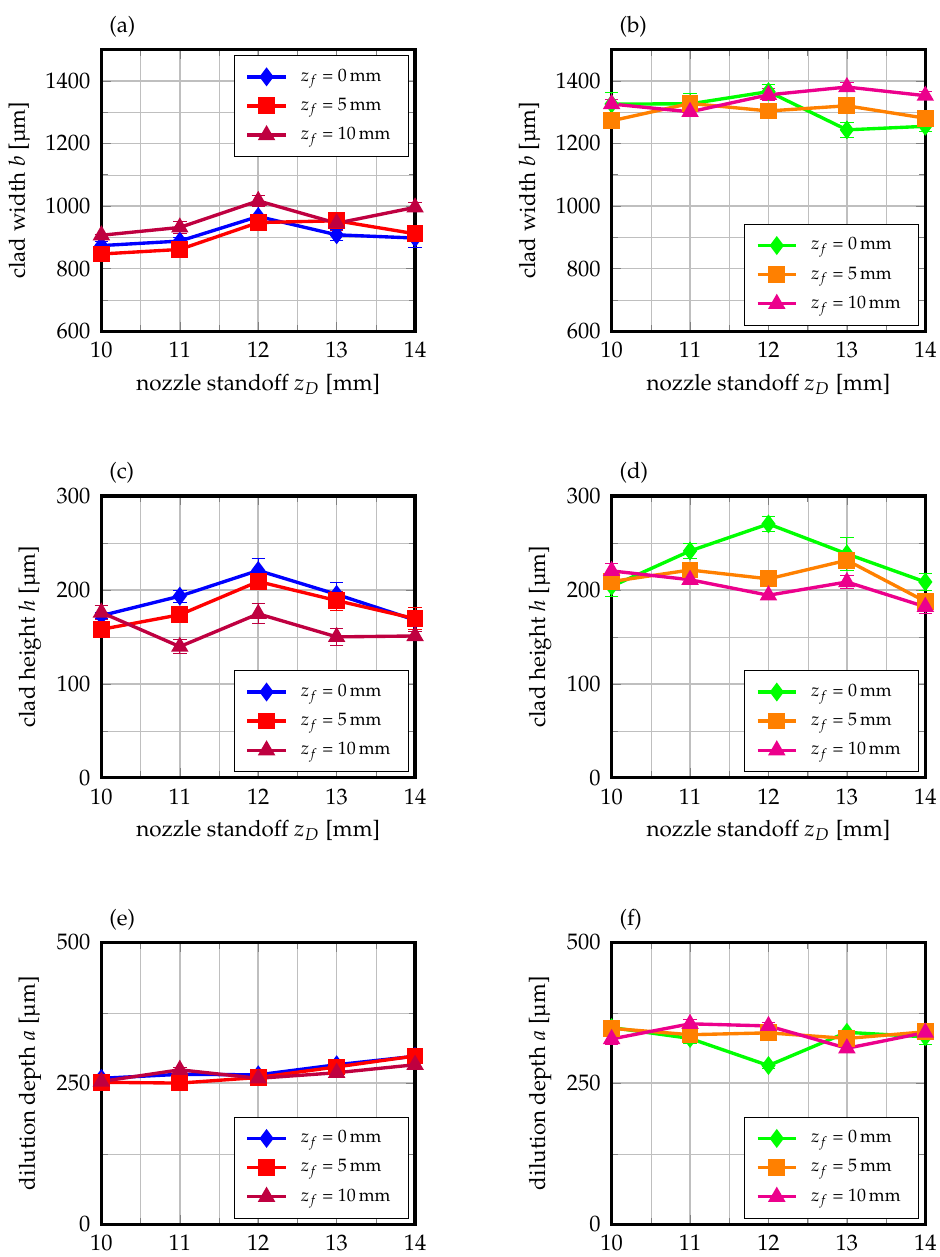
Figure 8. Evolution of target values’ clad width b , clad height h , and dilution depth a for varying nozzle standoff distances z D and focal offsets of the laser beam z f . Mean values of five measurements, with SEM. ( a , c , e ): Focal length F f = 200mm, ( b , d , f ): Focal length F f =